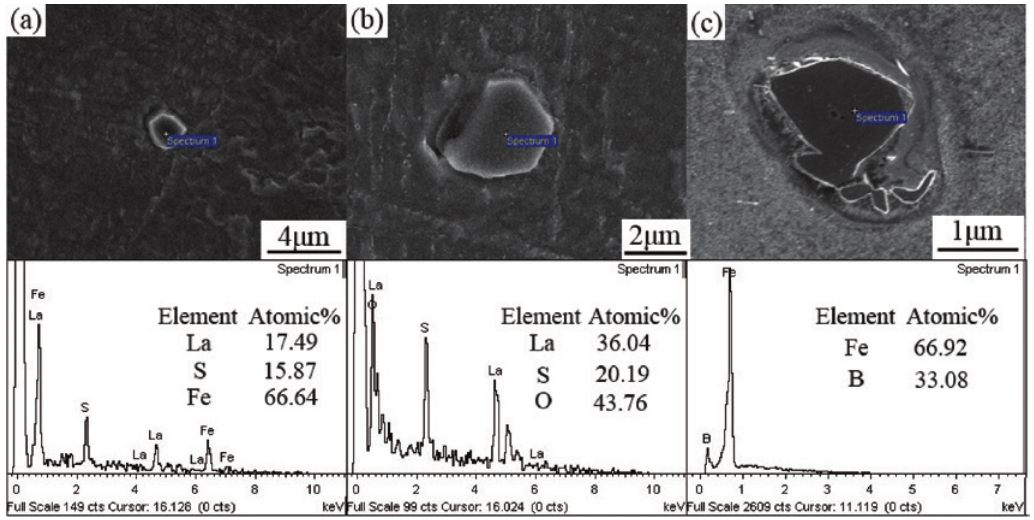
Fig. 4: FSEM images and EDS spectra of inclusions in the tested steels: (a) LaS; (b) La 2 O 2 S; (c) Fe 2 B